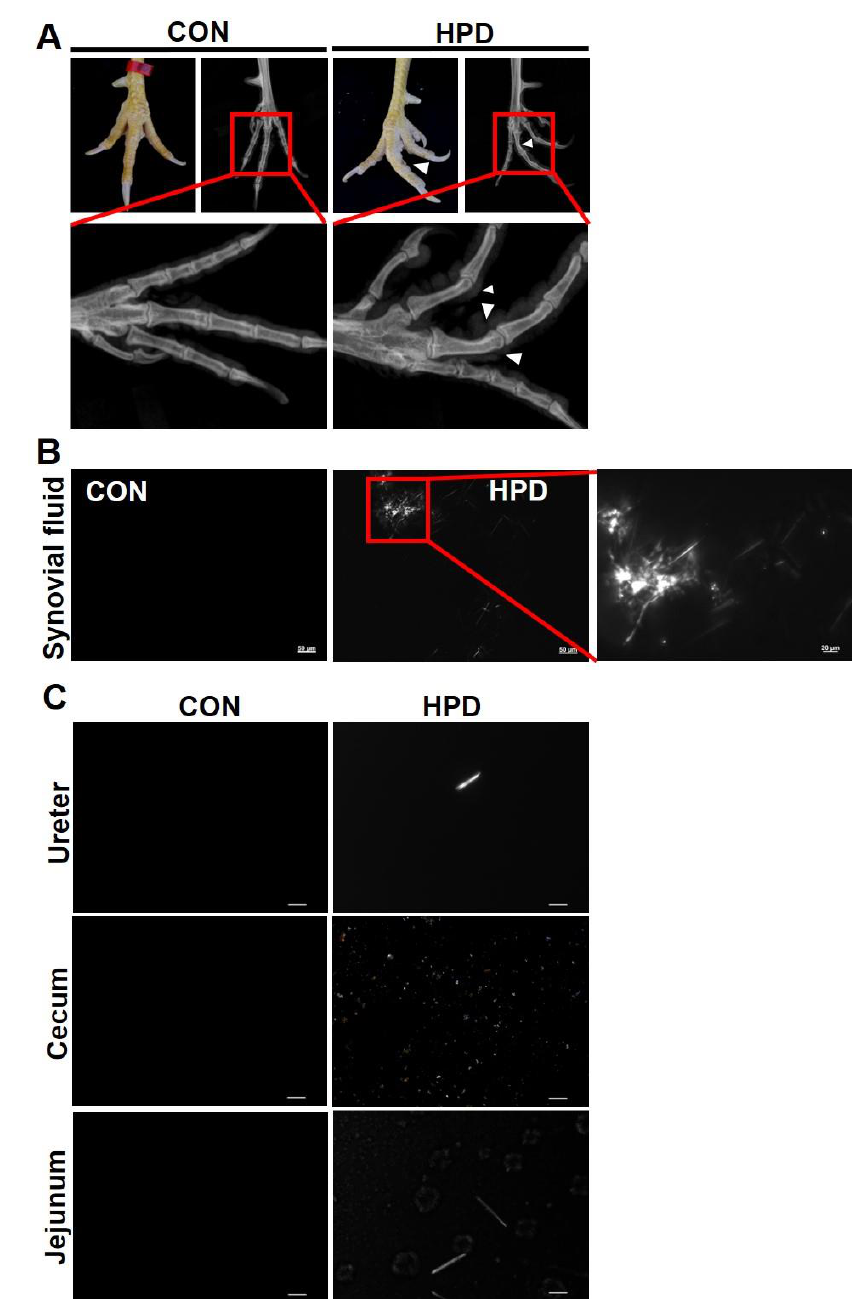
Figure 5. HPD induces monosodium urate (MSU) crystal production in synovial fluid and other tissue fluids. ( A ) Representative images of chicken claws in normal and X-ray conditions. ( B ) Representative images of MSU in synovial fluids using polarized light microscopy. (scale: 50 and 20 µm) ( C ) Representative images of crystal in the ureter, cecum, and jejunum fluids using polarized light microscopy (scale: 20 μm).